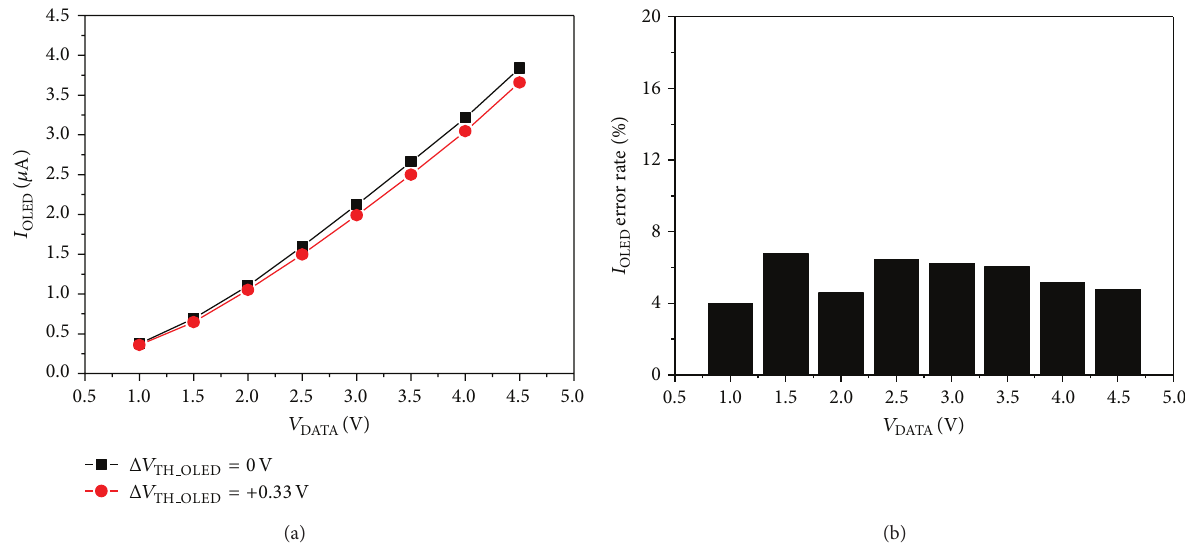
) is +0.33 V, with a voltage range TH OLED